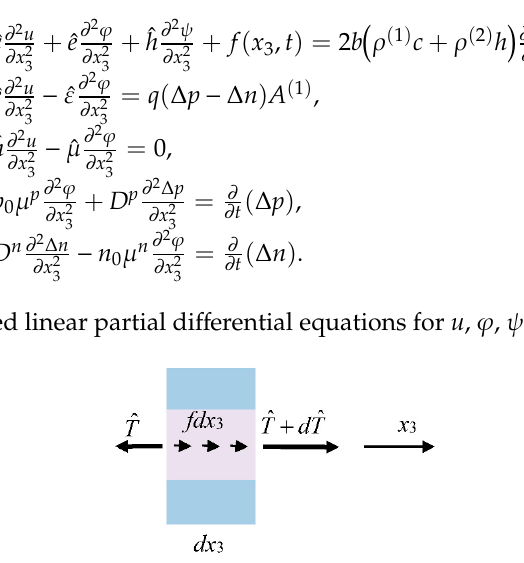
Figure 2. A differential element of the composite rod under mechanical loads. Figure 2. A di ff erential element of the composite rod under mechanical